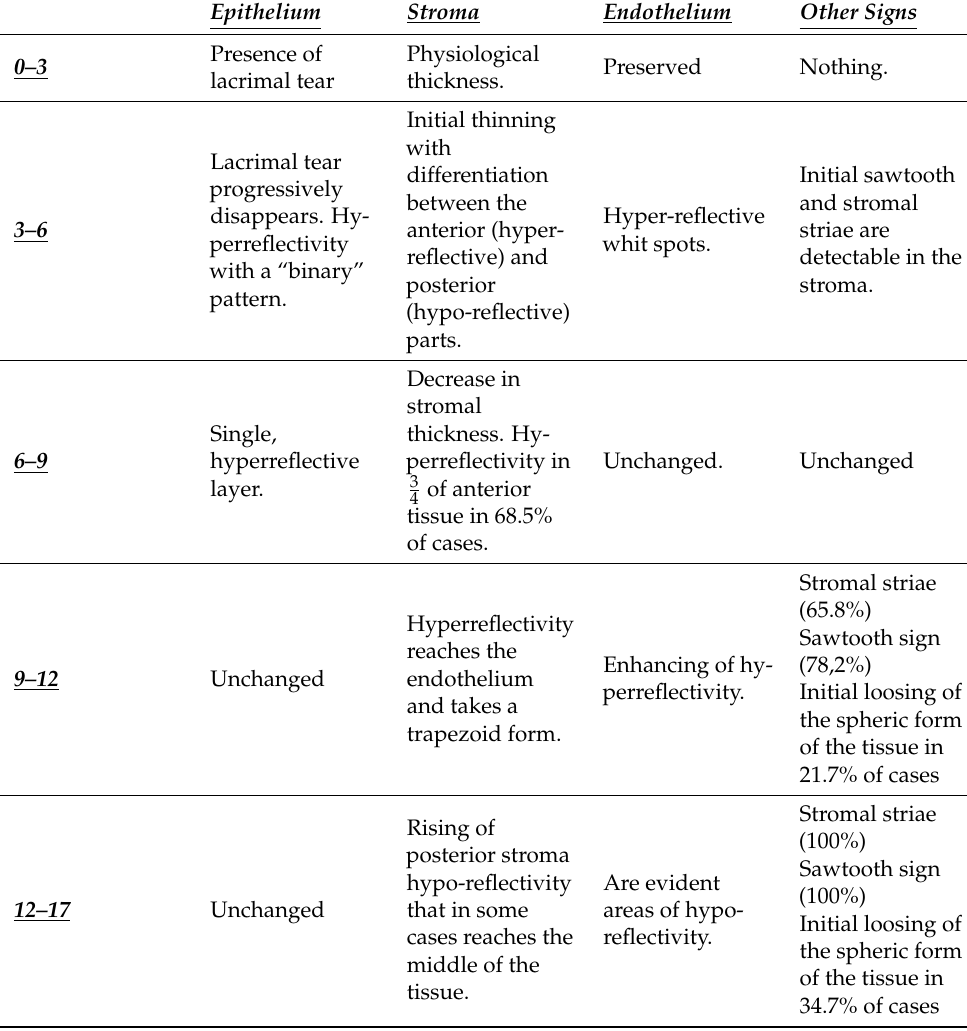
Table 1. Main changes in the open eyes in interval postmortem from 0 to 17